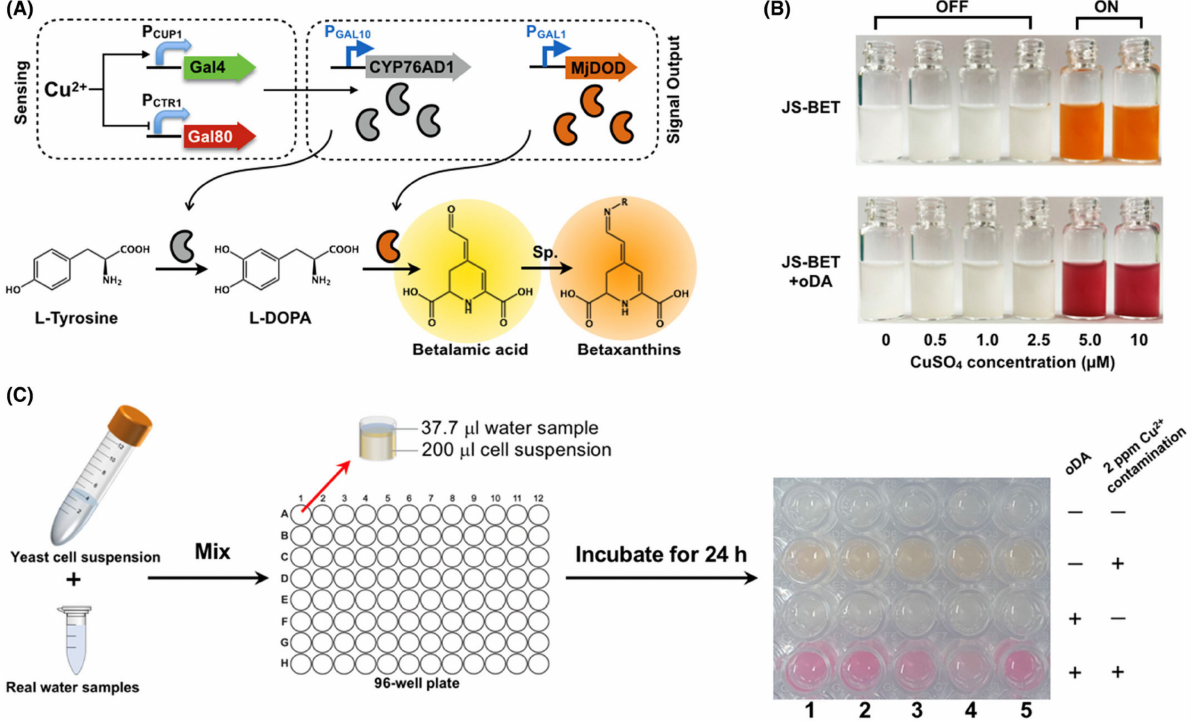
Figure 11. Betaxanthin-based biosensor for copper ion detection. ( A ) Schematic of copper ion detection, ( B ) detection using the biosensor phenotype, ( C ) various water sources with 2 ppm copper concentrations (reprinted with permission from Ref. no. [105], copyright 2022, John Wiley and